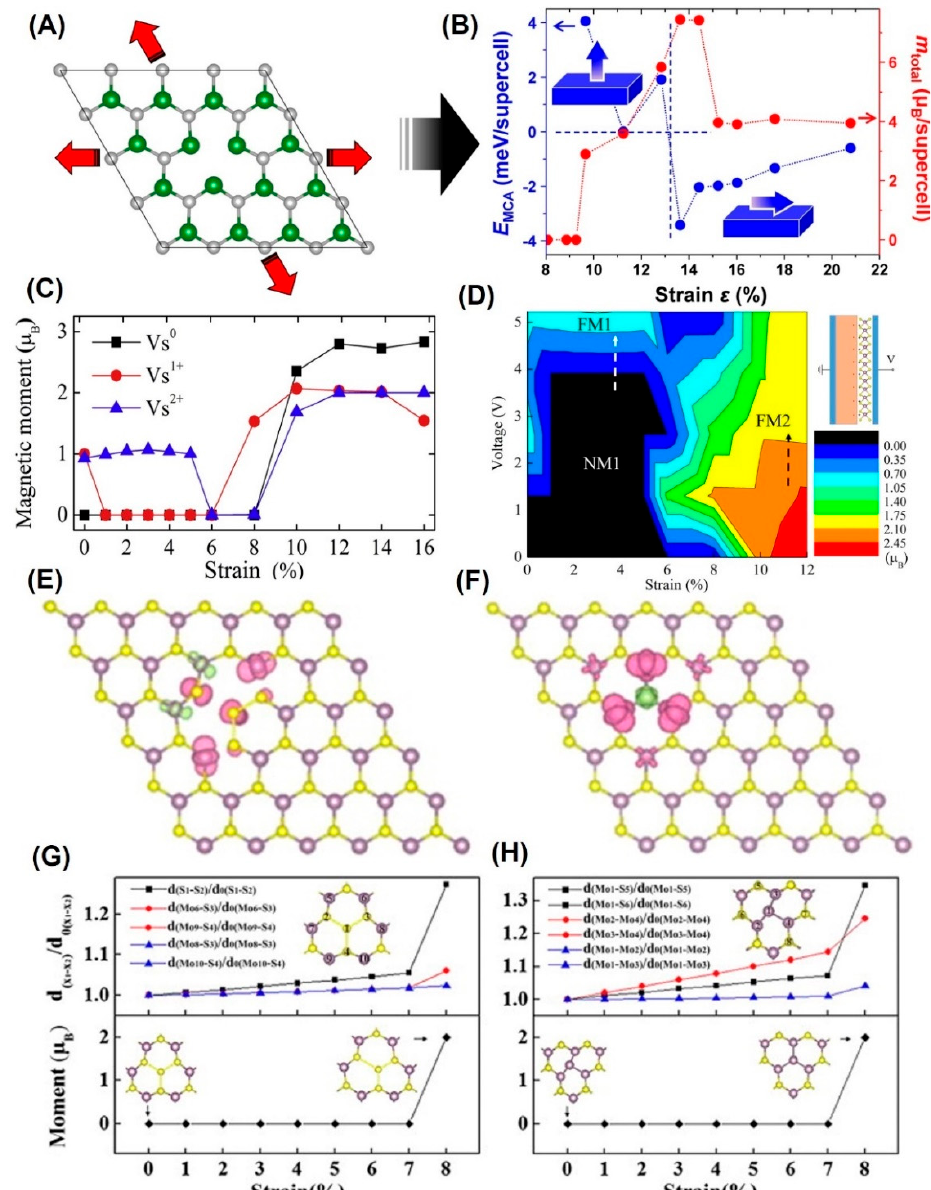
Figure 4. ( A ) Schematic illustration of MoS 2 ML with V 2S under biaxial tensile strain ( A ) Schematic illustration of MoS